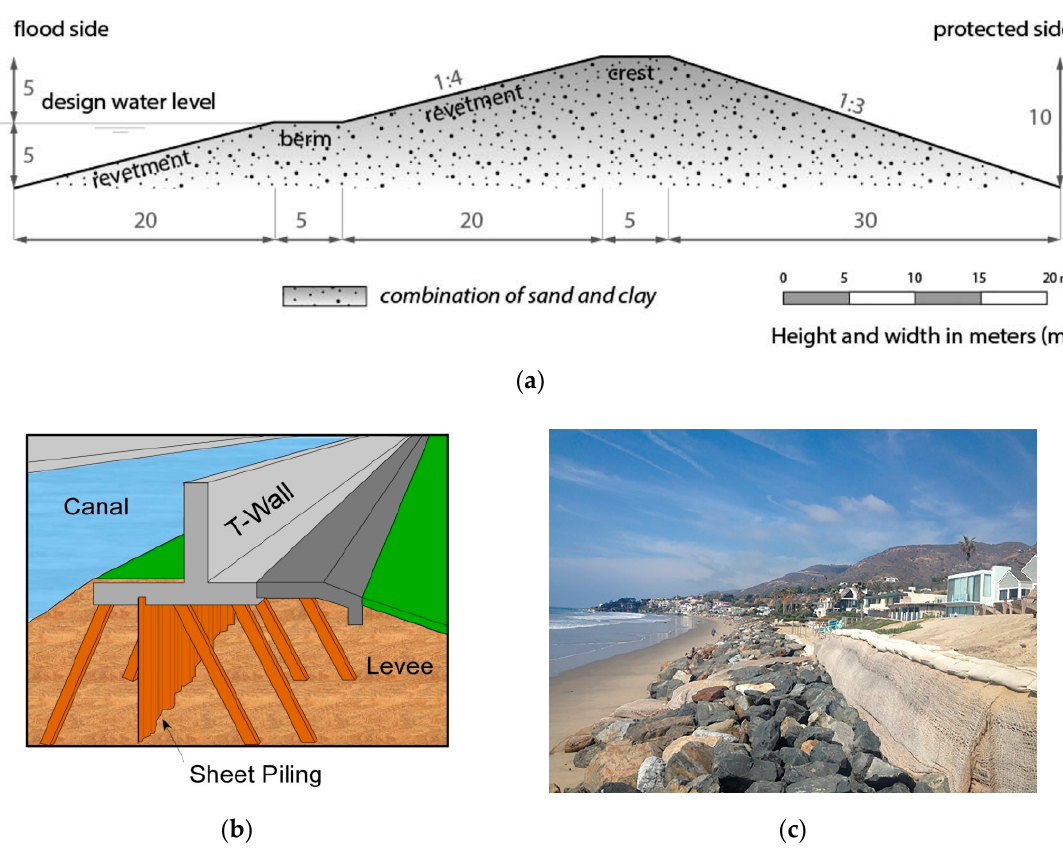
Figure 2. Types of flood protection: ( a ) a cross ‐ section of a typical Dutch sea ‐ dike, filled with sand and clay [14] ( b ) Two types of steel and concrete floodwalls applied [46] ( c ) Rip ‐ rap [17].